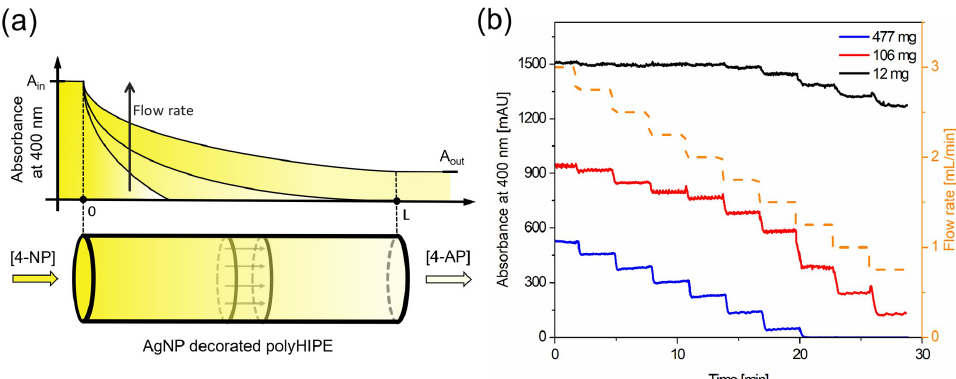
Figure 6. ( a ) Column schematic resembling continuous tubular reactor and absorbance profiles due to catalyzed reaction. ( b ) Experimentally measured absorbance at 400 nm (bold lines) for the reduction of 4-NP at flow rates between 0.75 and 3 mL/min (dashed line) is plotted. Absorbance corresponding to the inlet reagent solution was 1620 mAU. The baseline measured for a reaction solution without 4-NP was subtracted for all values. More details in Section